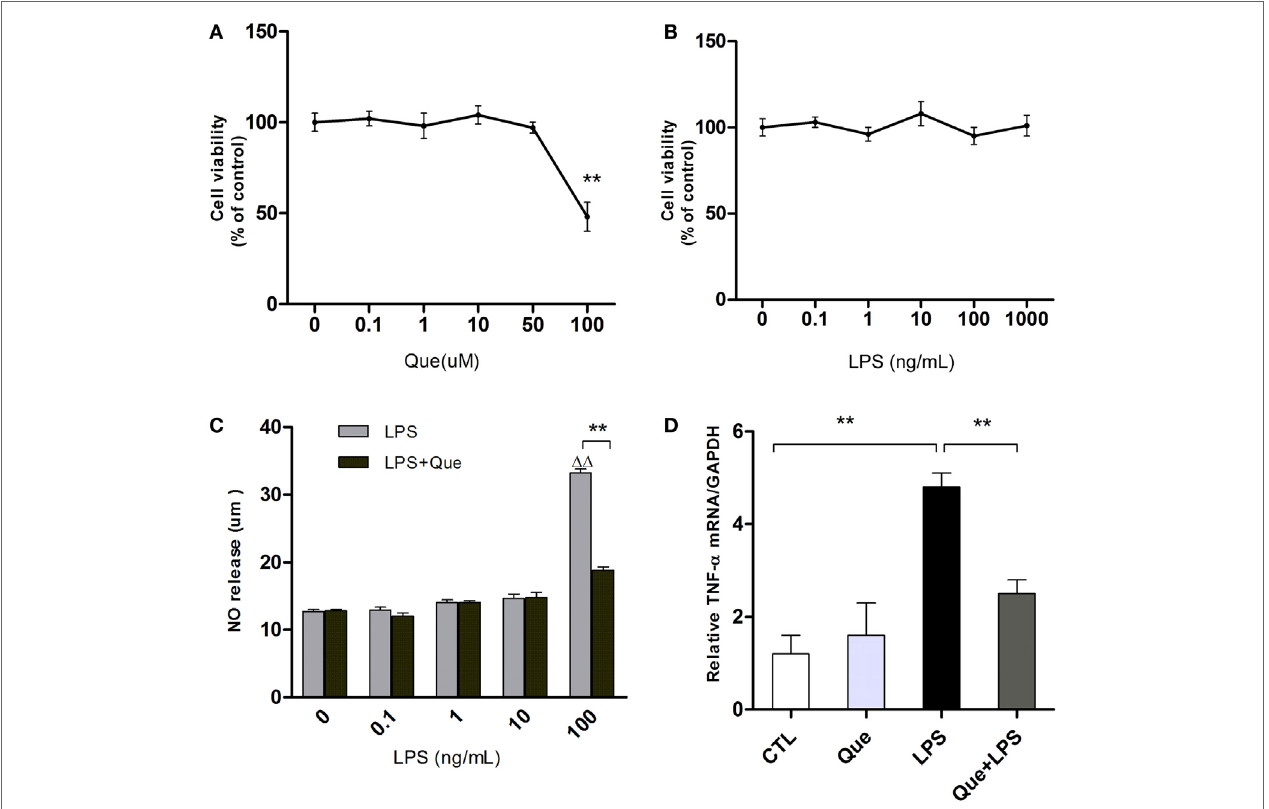
FigUre 2 | effect of Que on nO and TnF- α release from n9 cells induced by lPs . (a) MTT assay, cell viability of N9 microglial cells treated with various concentrations (0, 0.1, 1, 10, 50, and 100 μ M) of Que for 24 h. (B) MTT assay, cell viability of N9 microglial cells treated with various concentrations (0, 0.1, 1, 10, 100, and 1000 ng/ml) of LPS for 24 h. (c) Griess assay of NO release from N9 cells exposed to various concentrations of LPS for 24 h with or without Que (10 μ M) pretreatment. (D) qRT-PCR measurement of TNF- α mRNA expression in N9 cells exposed to LPS (100 ng/ml) for 24 h with or without Que (10 μ M) pretreatment. Data are represented as means ± SEM. ** p < 0.01 vs. indicated group ▵▵ p < 0.01 vs. control group (LPS =